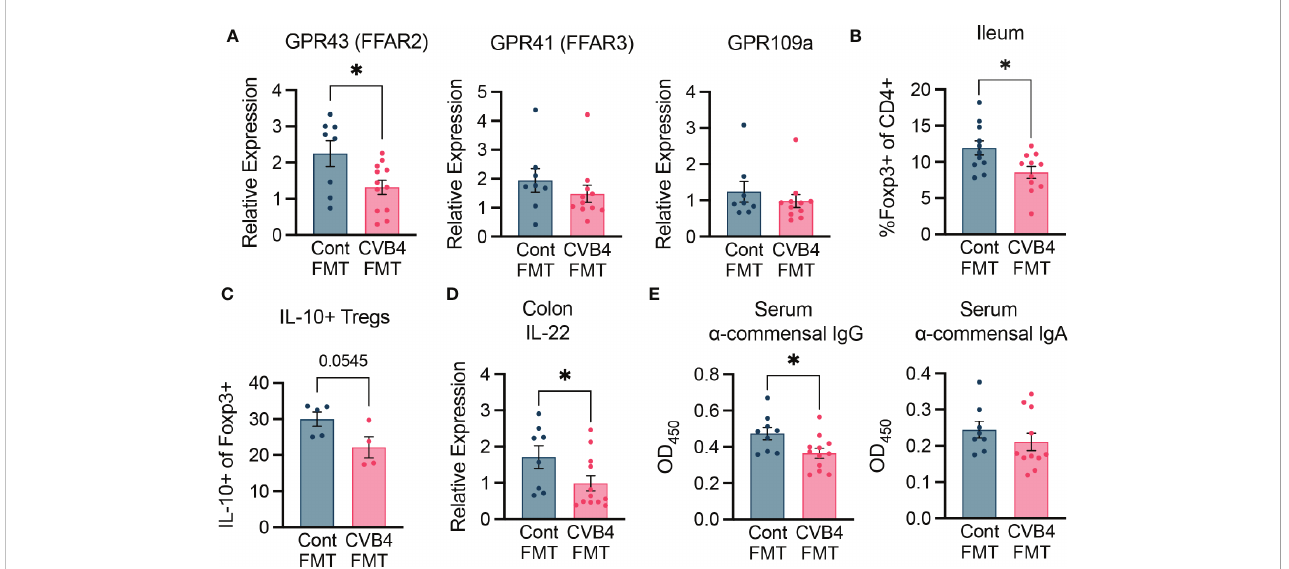
FIGURE 6 FMT modi fi es intestinal immunity (A) Expression of free fatty acid receptors in the proximal colon of FMT recipient mice. (B) Abundance of CD4 Foxp3+ regulatory T cells in the ileum of FMT mice. (C) Expression of IL-10 in the intestinal Tregs. (D) Expression of IL-22 in the proximal colon measured by RT- qPCR. Results were normalized to GAPDH and expressed as relative expression compared to age-matched naive controls. (E) Abundance of anti- commensal antibodies in the serum of FMT recipient mice as measured by ELISA. All samples were analyzed at day 35 post-FMT. All p values were calculated using paired Welch's test (two-tailed) from at least 2 independent experiments. *P<0.05 was considered statistically signi fi